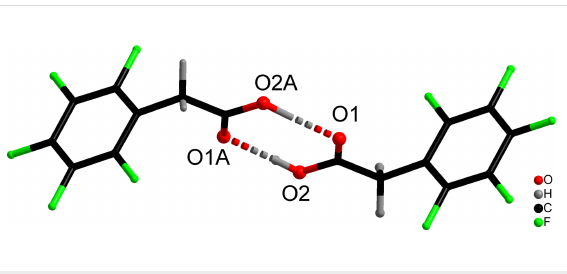
Since basic conditions seem to be unsuitable for the hydrolysis of diethyl 2-(perfluorophenyl)malonate, acid-catalyzed reac- tions were also tested. Trifluoroacetic acid (TFA) is a common reagent for the catalytic cleavage of tert -butyl esters, but in the stoichiometric quantity it is also suitable for the cleavage of nonvolatile methyl or ethyl esters due to transesterification [34,35]. The removal of highly volatile methyl or ethyl tri- fluoroacetates from the reaction mixture is the driving force of this process. Unfortunately, 2-(perfluorophenyl)malonate does not react with excess TFA (up to 10 equivalents) even under reflux conditions, but in one experiment a catalytic amount of concentrated H 2 SO 4 was added, and then coincidentally the reaction mixture was slightly overheated (to 100 °C), which led to the evaporation of the entire acid. The remaining solid was identified as 2-(perfluorophenyl)acetic acid ( 12 ). We believe that 2-(perfluorophenyl)acetic acid might be formed by thermal